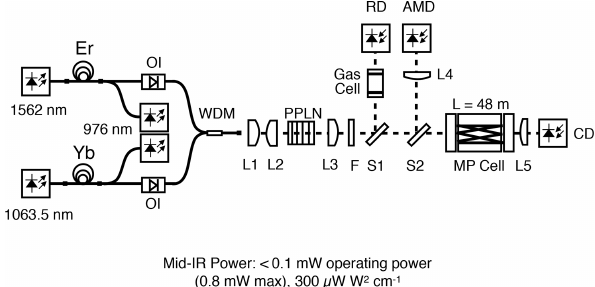
Figure 2. Mid-IR source schematic. Er: erbium-doped fiber; Yb: ytterbium-doped fiber; OI: optical isolator; WDM: wavelength divi- sion multiplexer; L1-5: lens; PPLN: periodically poled lithium nio- bate; F: Ge filter; S1-2: beam splitter; MP cell: multi-pass cell; RD: reference detector; AMD: amplitude modulation detector; CD: cell